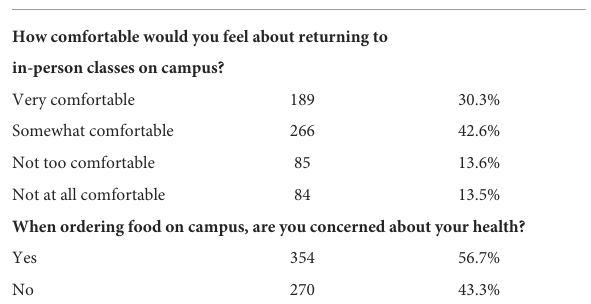
TABLE 1 Socio-demographic characteristics of the study participants ( n = 624).